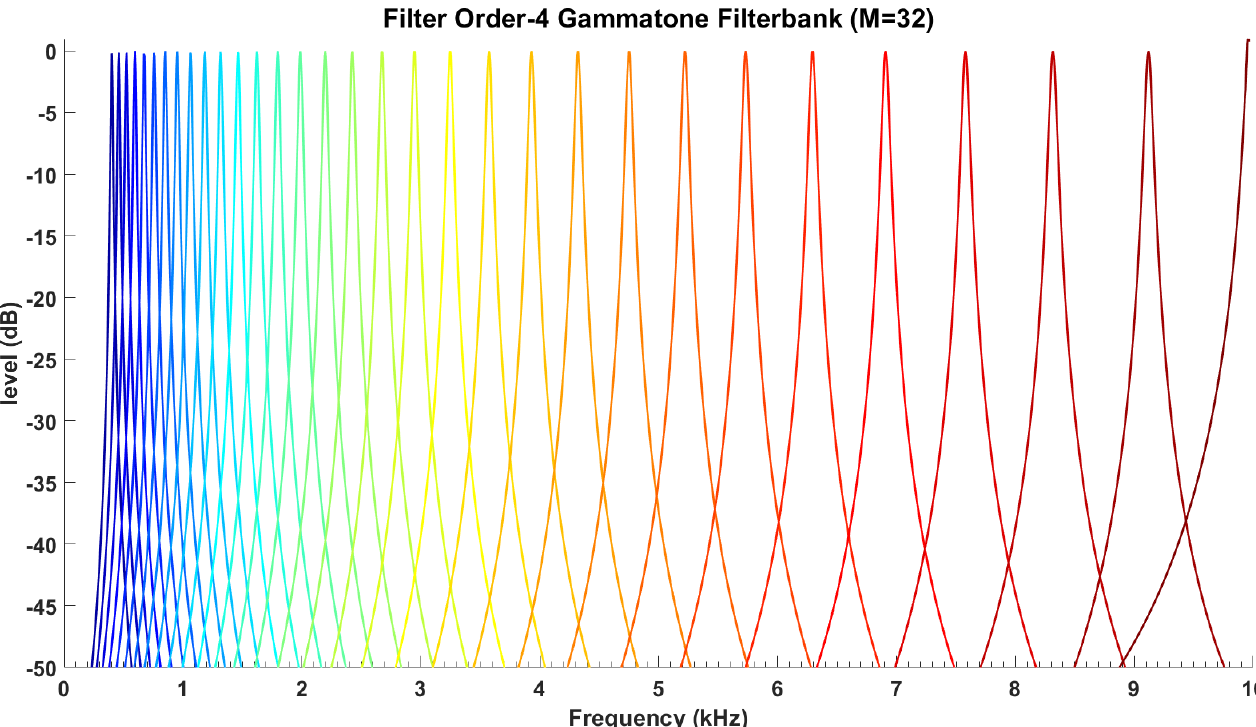
Figure 6. The frequency response of gammatone filter-banks.